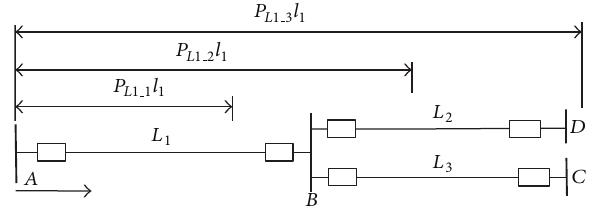
Figure 2: Protection area of zones 1, 2, and 3 distance